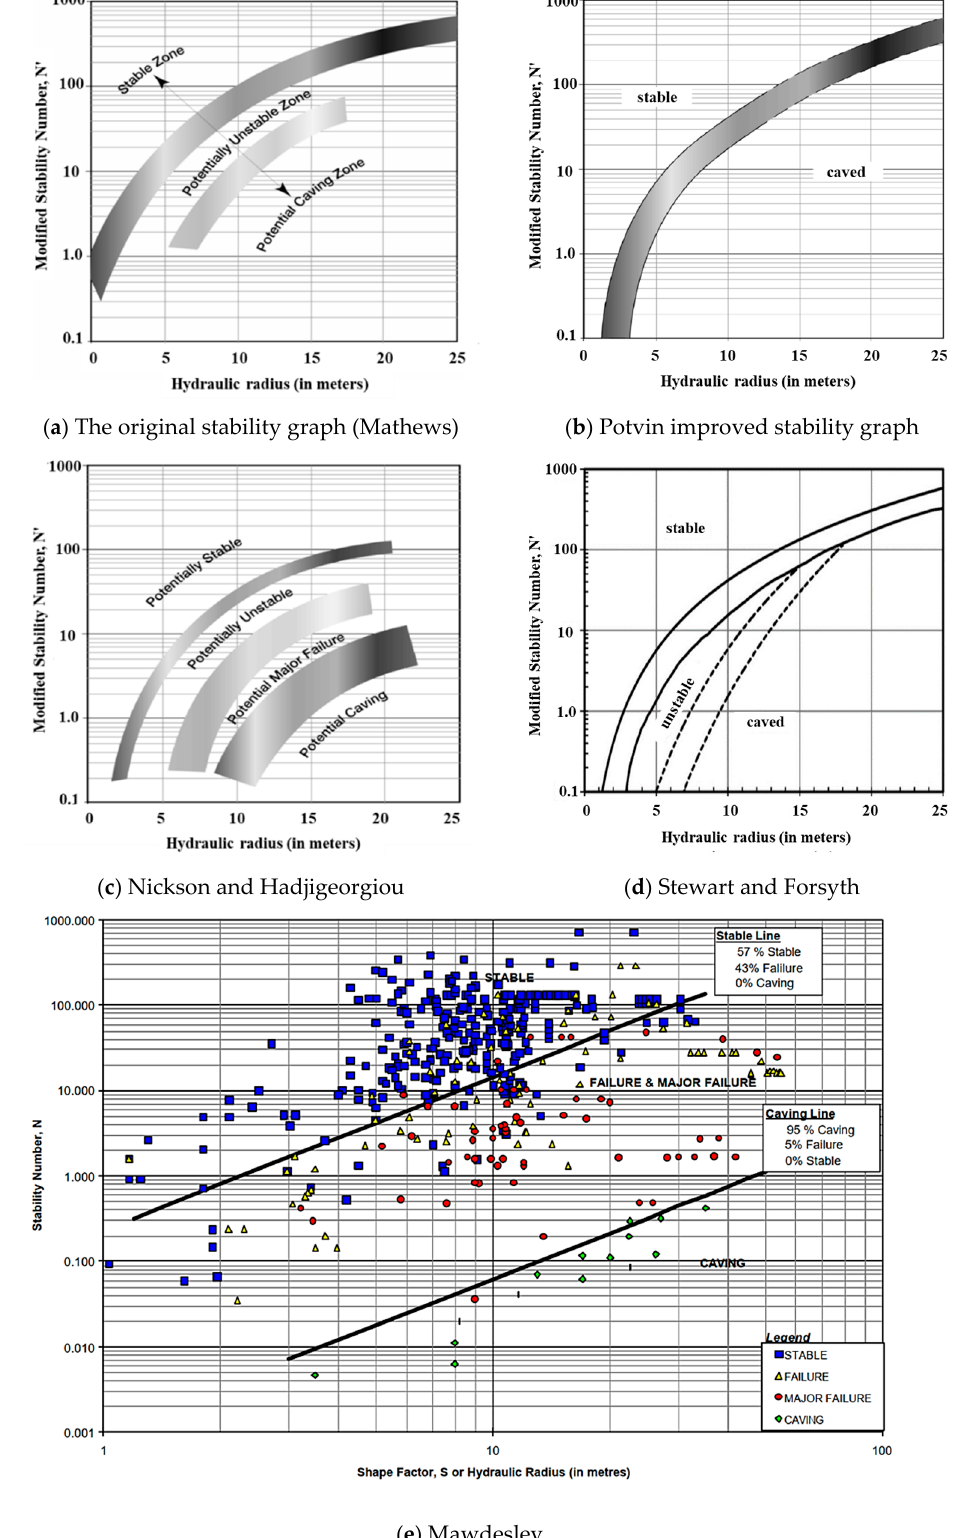
Figure 5. Stability graph development process. ( a ) The original stability graph (Mathews); ( b ) Potvin improved stability graph; ( c ) Nickson and Hadjigeorgiou improved stability graph; ( d ) Stewart and Forsyth improved stability graph; ( e ) Mawdesley improved stability graph.